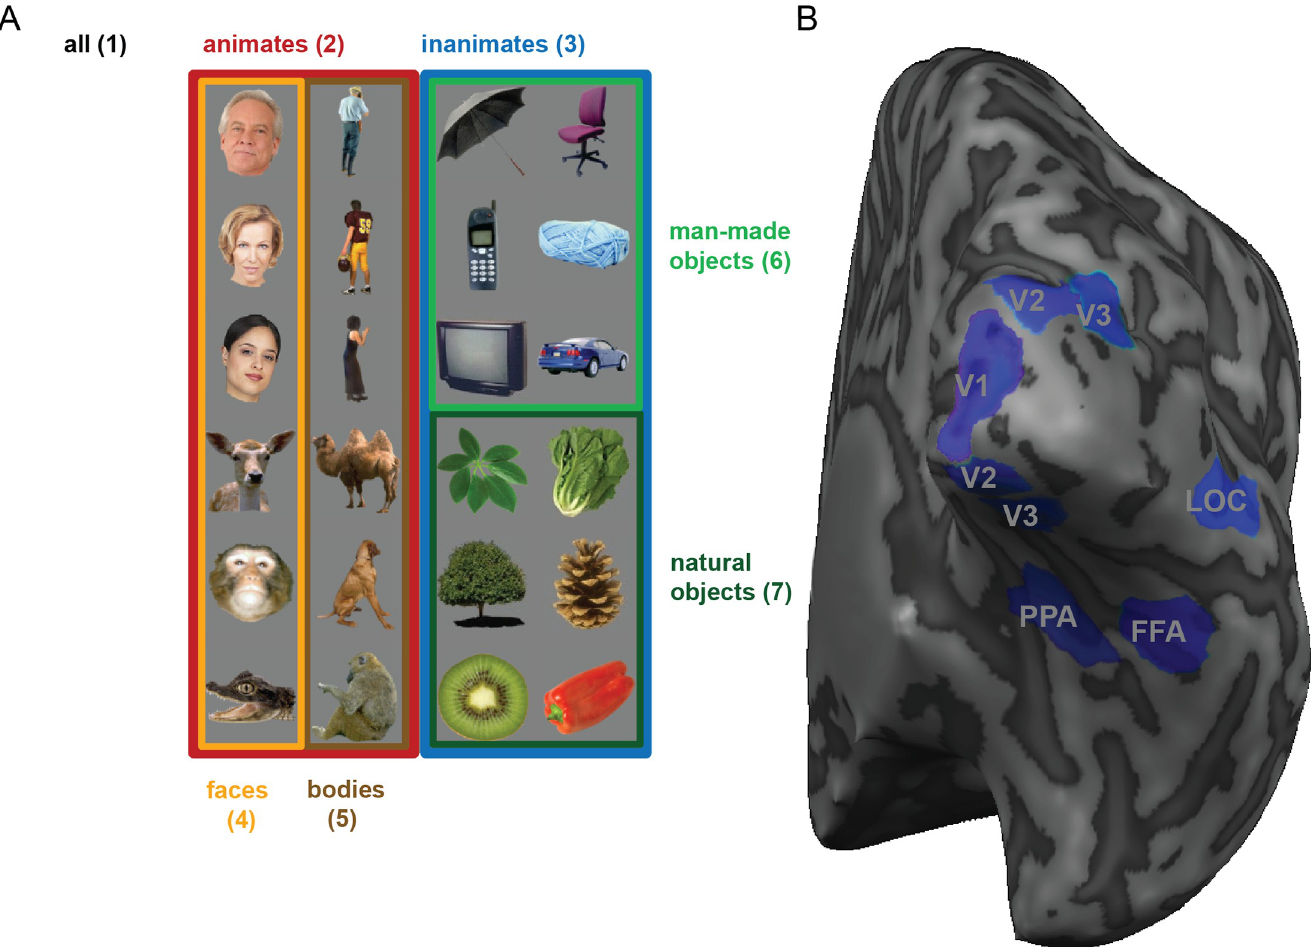
Fig 5. Different exemplar sets (A) and ROIs (B) considered for the analysis of real fMRI data. In order to evaluate the different tests, we apply the tests to real fMRI data. Having data from different regions of interest (V1, V2, V3, LOC, FFA and PPA, displayed for an example subject on the right) and testing the discriminability for different exemplar sets ( i . e . different sets of experimental conditions, displayed on the left) confronts the tests with a wide range of situations. To obtain an estimate of the type I error, different tests were applied to randomised fMRI data (simulating the null hypothesis with real data). Seven subsets of conditions are considered: 1) all 24 images 2) 12 images belonging to the animate category 3) 12 images belonging to the inanimate category 4) 6 face exemplars 5) 6 images of bodies 6) 6 man-made objects 7) 6 natural objects.